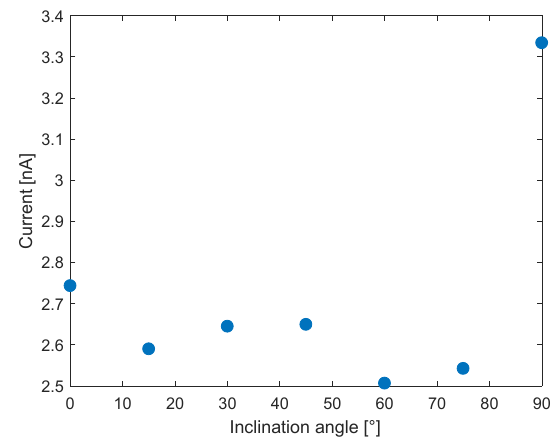
Figure 9. Photocurrent as a function of inclination of the MSPD detector at a 85km altitude, for the seven different inclination angles simulated. The material considered is stainless steel and the solar zenith angle is 75 ◦